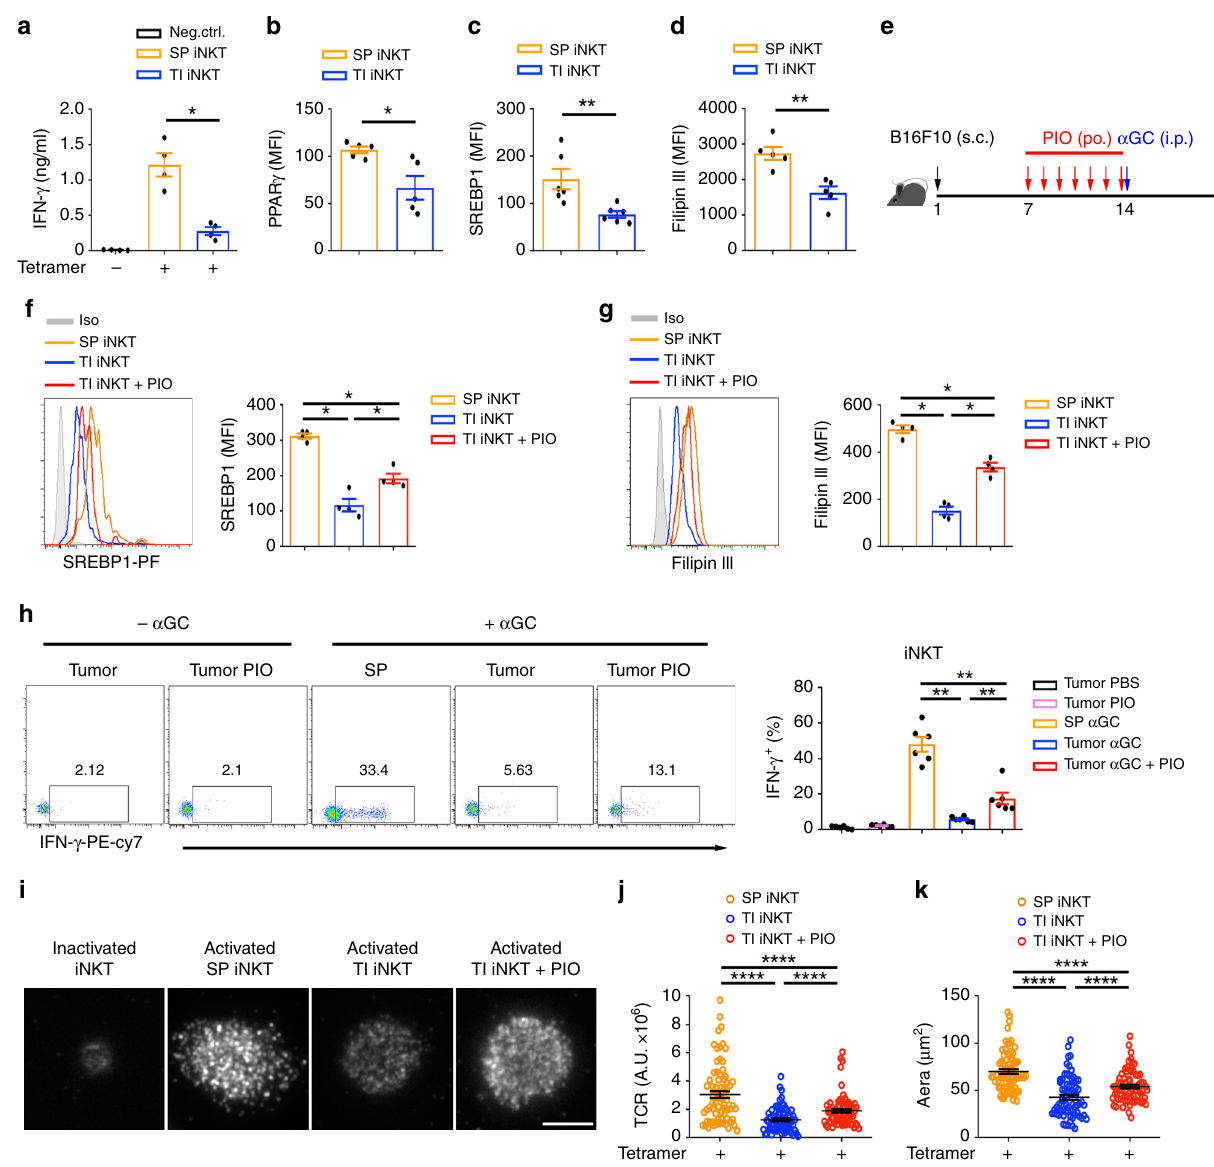
Fig. 6 PIO restores cholesterol and IFN- γ production in tumor-in fi ltrating iNKT cells in vivo. a IFN- γ production in tumor-in fi ltrating (TI) iNKT cells and splenic (SP) iNKT cells from B16F10 tumor-bearing mice, after activating with plate-coated mCD1d-PBS57 tetramer. b – d PPAR γ ( b ), SREBP1 ( c ), and Filipin III staining ( d ) in TI iNKT cells and SP iNKT cells from B16F10 tumor-bearing mice. e Timeline of experimental procedure. f – h SREBP1 expression ( f ) and Filipin III staining ( g ) of iNKT cells, and percentages of IFN- γ + iNKT cells ( h ) from indicated tissues of B16F10 tumor-bearing mice, after treating with or without PIO for 7 days and injecting with 2 μ g α GC for 5 h. i – k Distribution ( i ) and fl uorescence intensity ( j ) of surface TCR, and area of immunological synapse ( k ) of iNKT cells, after activating with coverslip-coated CD1d-PBS57 tetramer for 45 min. Cells from indicated tissues were isolated from mice treating with or without PIO for 7 days ( n = 80 cells per group). Bar, 5 μ m. Data are means ± SEM of four mice ( a , f , g ), fi ve mice ( b , d ), or six mice ( c , h ), pooled from three independent experiments. Data were analyzed by Mann – Whitney test ( a – d , f – h ) or unpaired Student ’ s t -test ( j , k ). * P < 0.05, ** P < 0.01, **** P < 0.0001. Source data are provided as a Source Data fi